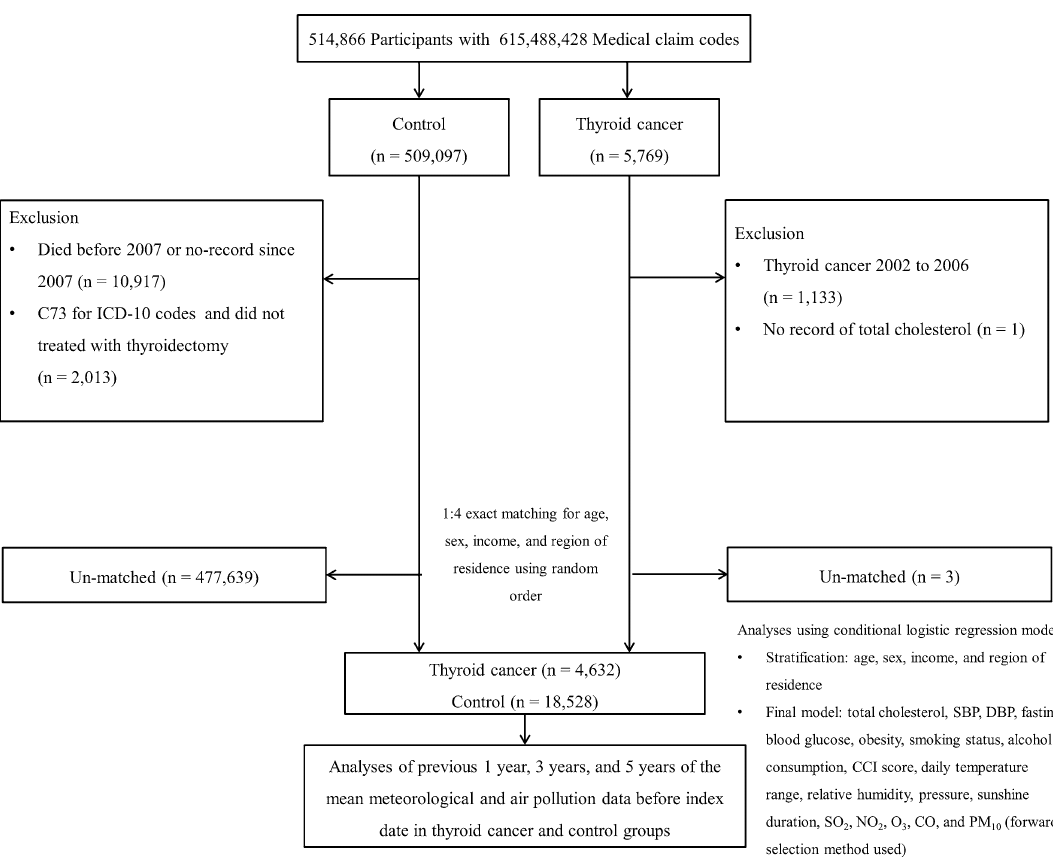
Figure 1. A schematic illustration of the participant selection process that was used in the present study. Of a total of 514,866 participants, 4632 thyroid cancer participants were matched with 18,528 control participants for age, sex, income, and region of residence. Then, the thyroid cancer and control groups were linked with meteorological data and air pollution data before the index